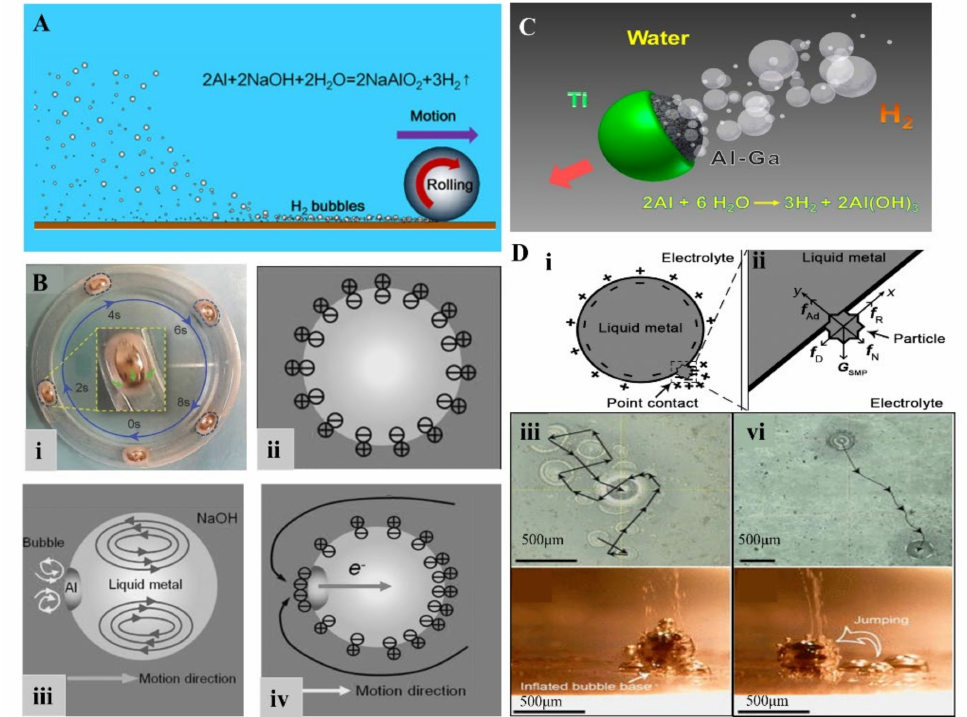
Figure 10. Chemically propelled MLMTs in H 2 O or NaOH. ( A ) Schematic illustration of the self- powered MLMTs [83]. ( B ) EGaIn-Al motors ( i ) Schematic for the running of EGaIn-Al motors in the circular channel. ( ii )–( iv ) Schematic illustration of the bipolar electrochemical mechanism [96]. ( C ) Ni-LM motors ( i ) Schematic illustration of the generation of H 2 bubbles: point contact-induced surface charge accumulation. ( ii ) Force analysis of Ni particles contacted with LM. ( iii ) Ni-LM motors roll on a hydrophilic quartz substrate. ( vi ) Ni-LM motors jump on a hydrophobic PP substrate [98]. ( D ) Schematic illustration of water-driven hydrogen propelled MLMTs